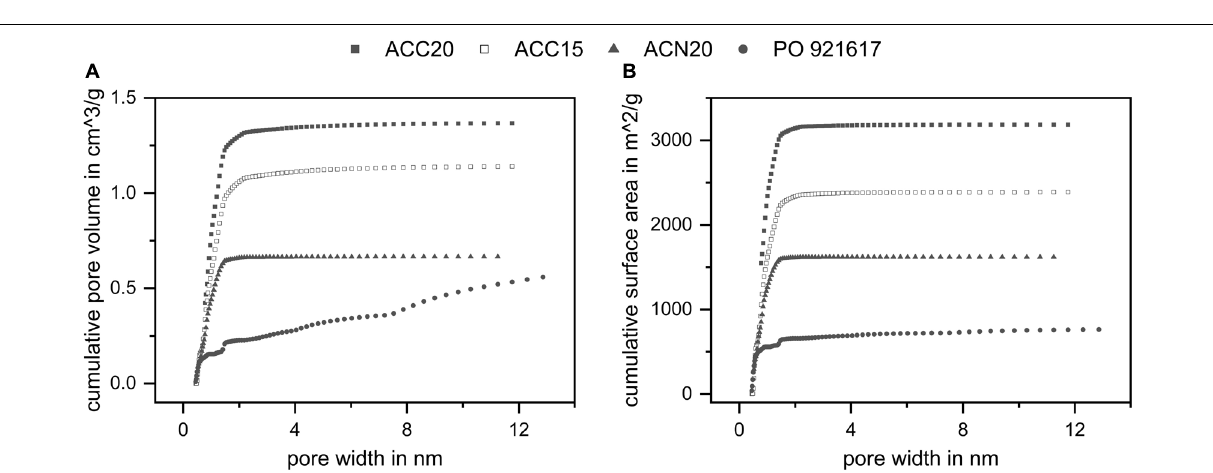
FIGURE 3 | Results of the BET measurements. (A) Cumulative pore volume and (B) cumulative surface area in dependency of the pore size. All materials show high surface areas and high pore volumes. The results indicate narrow pore size distributions for ACC20, ACC15, and ACN20 as well as a broader distribution for